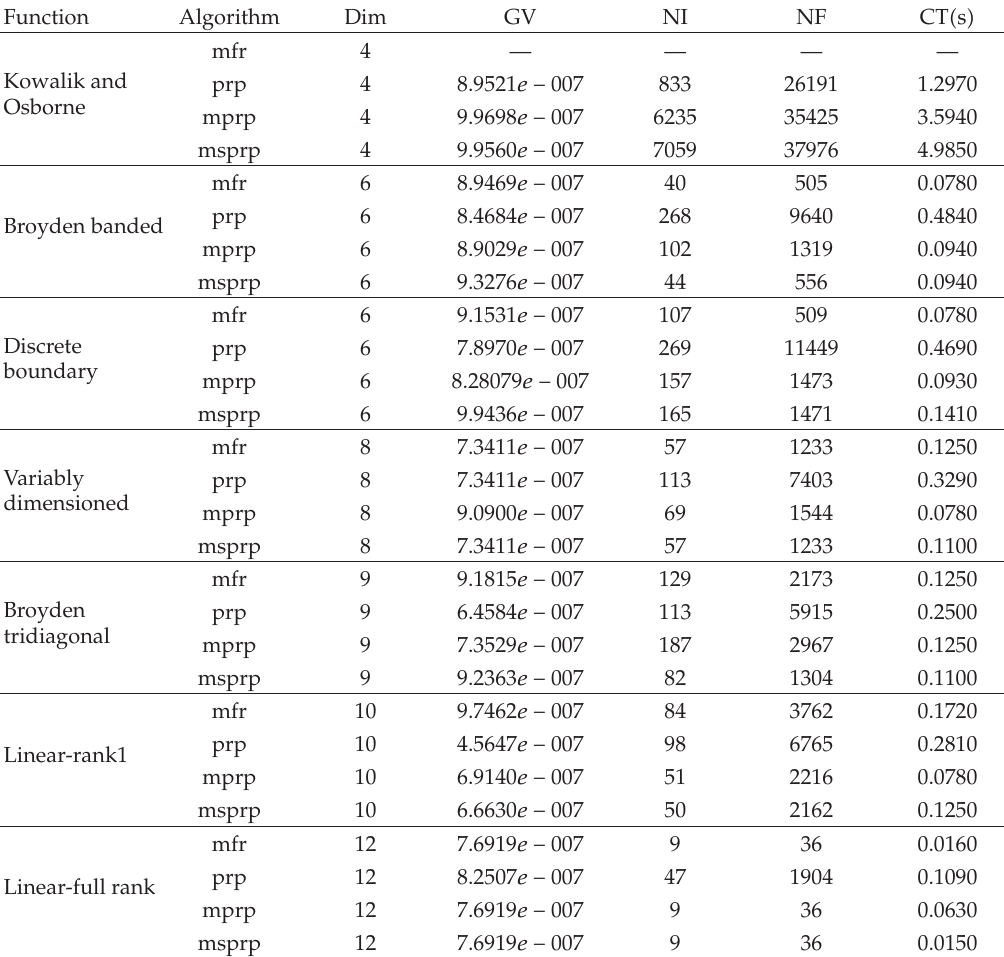
Table 2: Comparison of e ffi ciency with the other